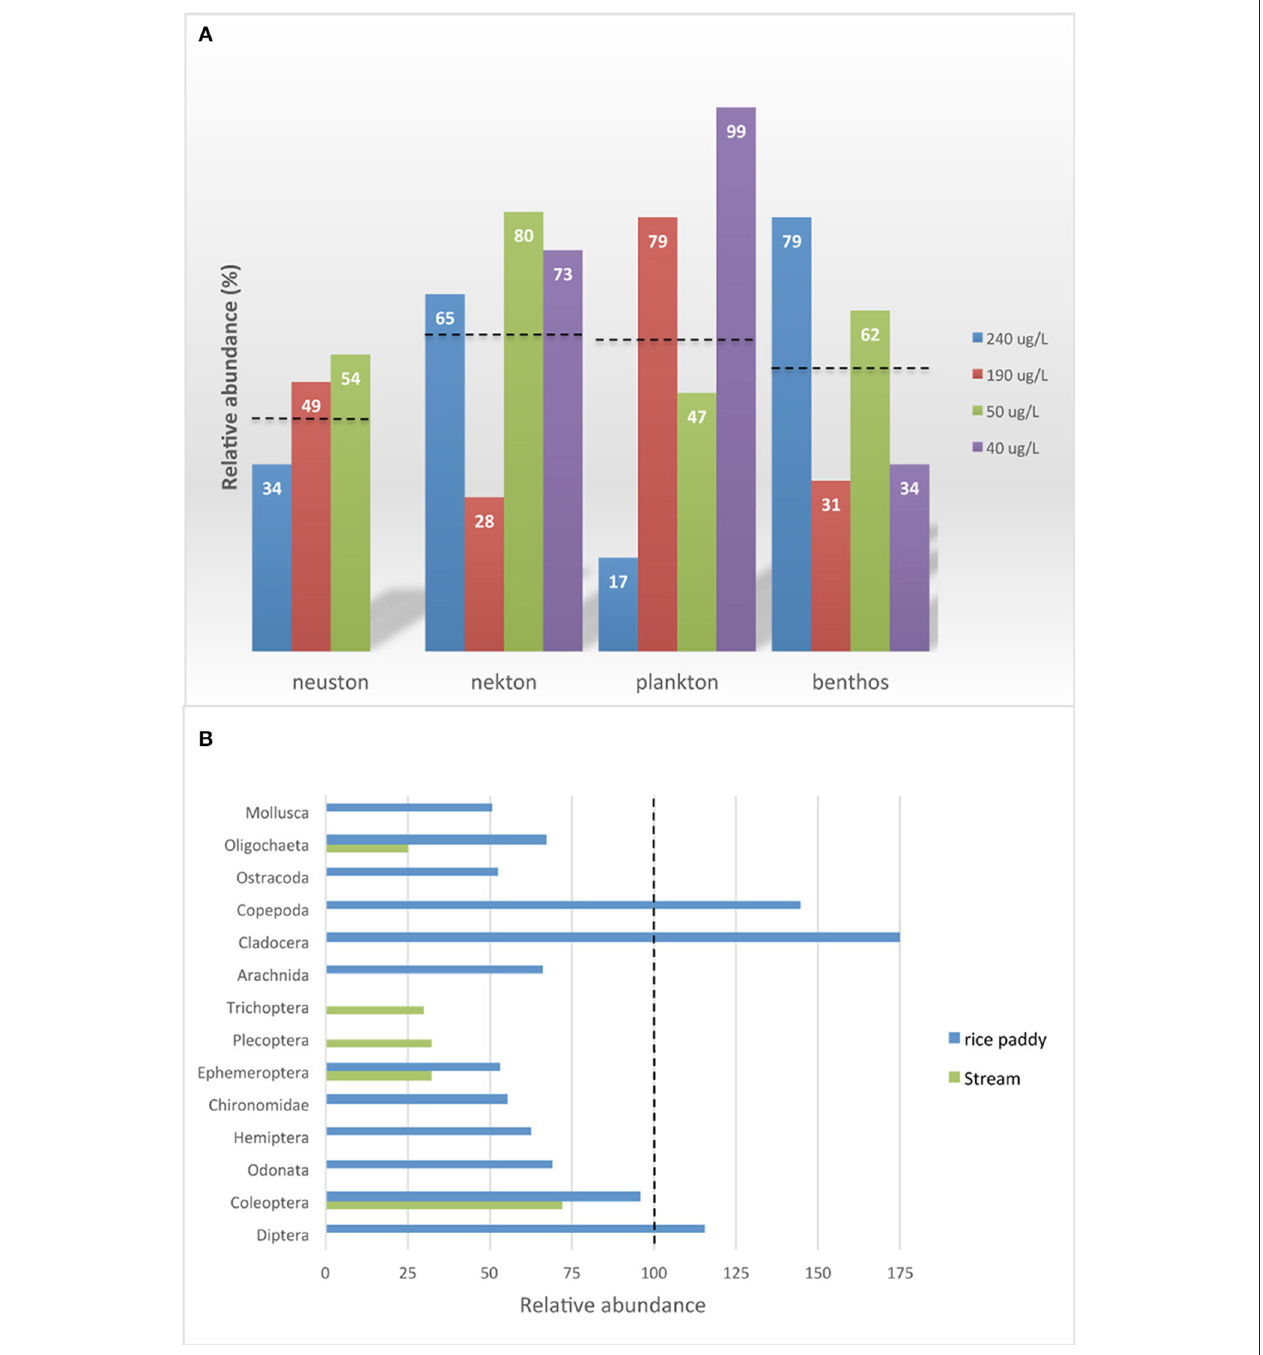
FIGURE 6 | Relative abundance with respect to controls of aquatic invertebrates in imidacloprid-treated mesocosms. (A) Communities in rice paddies for different initial concentrations of imidacloprid; dashed lines indicate average reductions. (B) Invertebrate taxa in rice paddies and streams; vertical dashed line indicates the control. Data sources: rice paddies (Sánchez-Bayo and Goka, 2006a; Sánchez-Bayo et al., 2007; Hayasaka et al., 2012a,b); streams (Pestana et al., 2009).